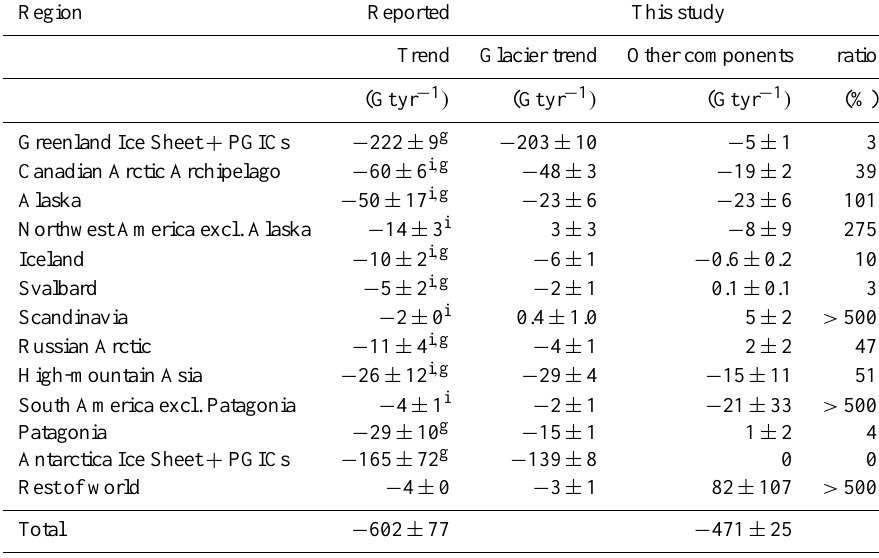
Table 5. Published trends in glacier water storage (Gardner et al., 2013; Jacob et al., 2012) compared to estimates from reanalysis. Uncer- tainties are given at the 95% (2 standard deviation) interval. Also listed are regional trends attributed to other parts of the hydrological cycle, and the ratio of the relative magnitude of those residual trends over estimated glacier mass change. Region Reported This study Trend Glacier trend Other components ratio (Gtyr − 1 ) (Gtyr − 1 ) (Gtyr − 1 ) (%) Greenland Ice Sheet + PGICs − 222 ± 9 g − 203 ± 10 − 5 ± 1 3 Canadian Arctic Archipelago − 60 ± 6 i , g − 48 ± 3 − 19 ± 2 39 Alaska − 50 ± 17 i , g − 23 ± 6 − 23 ± 6 101 Northwest America excl. Alaska − 14 ± 3 i 3 ± 3 − 8 ± 9 275 Iceland − 10 ± 2 i , g − 6 ± 1 10 Svalbard − 5 ± 2 i , g Scandinavia Russian Arctic High-mountain Asia South America excl.